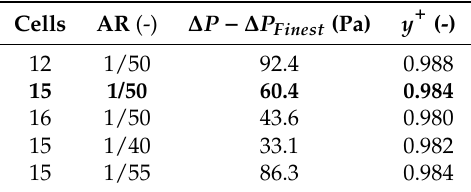
Table 3. Tip mesh